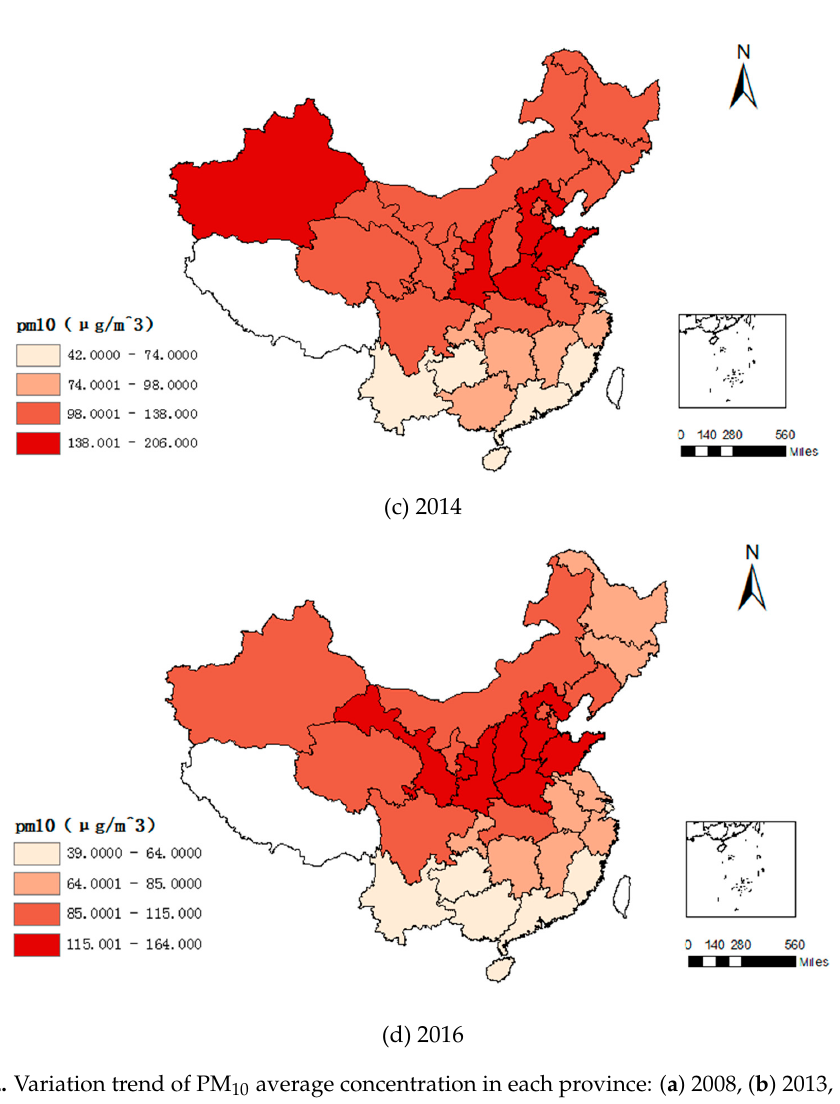
Figure 2. Variation trend of PM 10 average concentration in each province: ( a ) 2008, ( b ) 2013, ( c ) 2014, ( d )